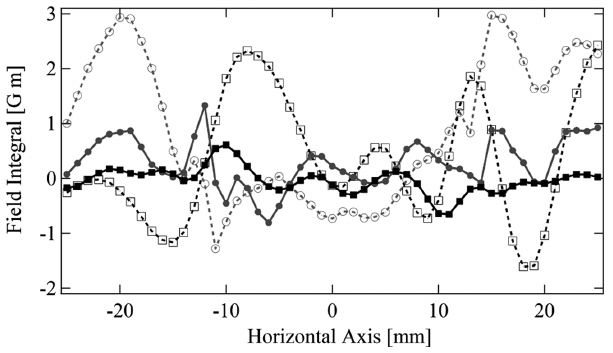
undulator.FIG. 6. Field integrals versus horizontal position at minimum gap of 5.5 mm at room temperature. (Filled square) Vertical field integral (Iz) after magic finger corrections. (Filled circle) Horizontal field integral (Ix) after magic finger corrections. (Open square) Vertical field integral (Iz) before magic finger corrections (Open circle) Horizontal field integral (Ix) before magic finger corrections. Field integrals precision is ∼ 0 . 05 G